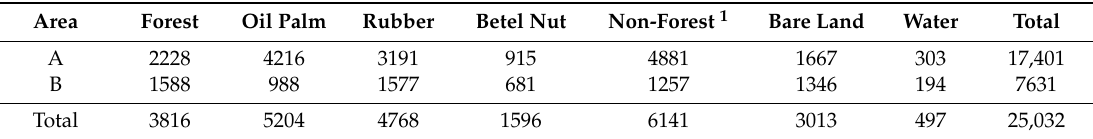
Table 4. Reference data collected for training and validation.